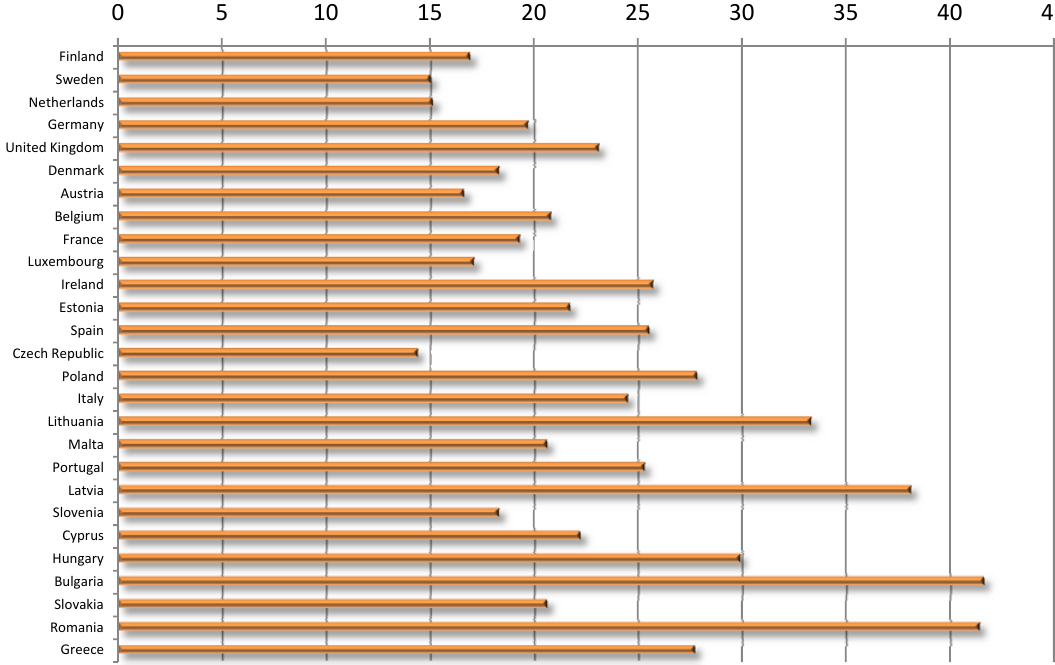
Figure 4. Persons at risk of poverty or social exclusion, 2010, % of total population